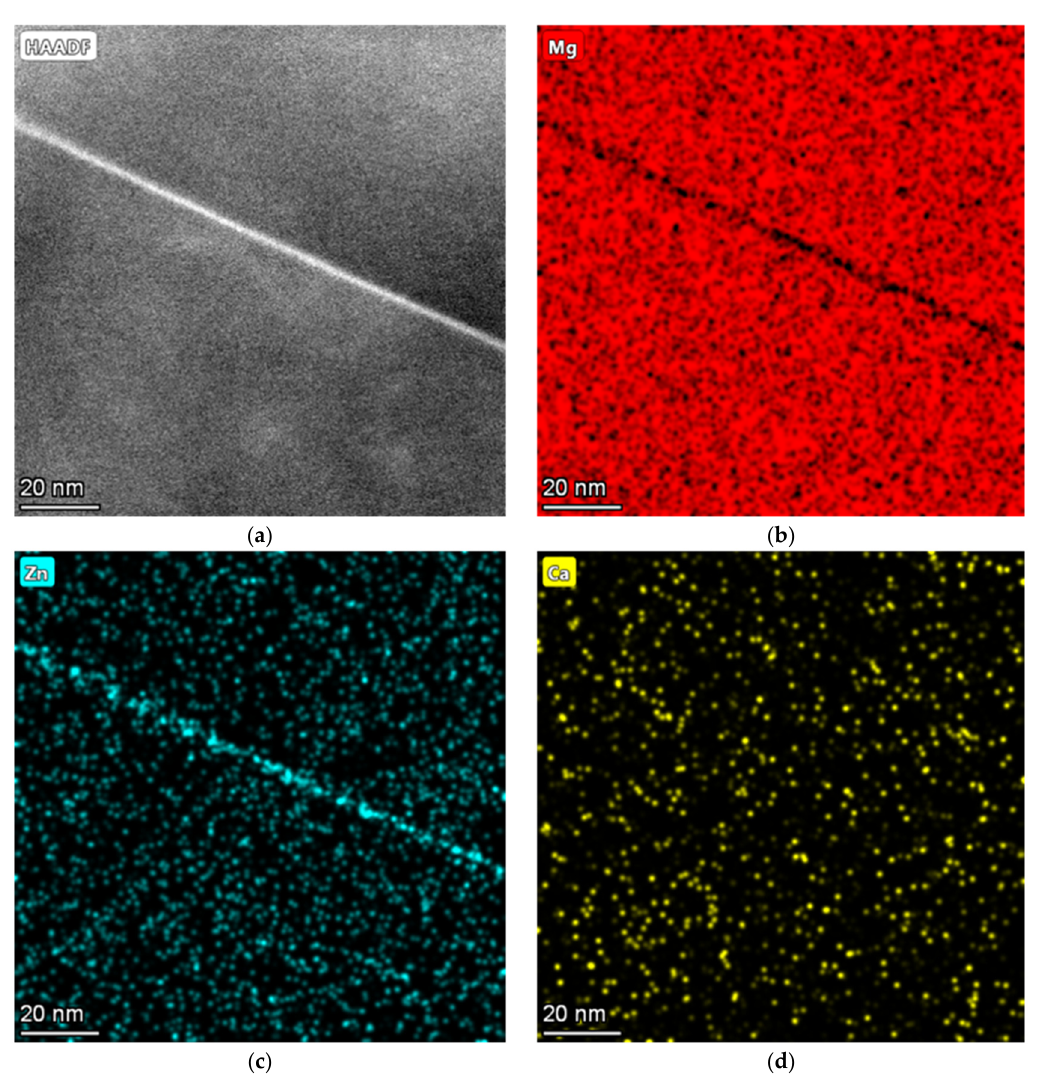
Figure 8. HAADF-STEM image and corresponding EDX maps of the as-extruded Mg-2Al-0.5Ca- 0.6Zn alloy: ( a ) HAADF-STEM image, ( b - d ) EDX maps of ( b ) Mg element, ( c ) Zn element and ( d ) Ca elements.